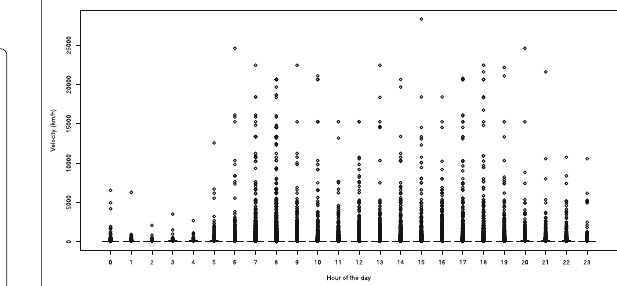
ger, light-goods and heavy-goods vehicles. The number of vehicles, common locations, entry-exit behavior, stopping locations and trajectories of different vehicle categories can be compared to each other. This should lead to a bet- ter understanding of urban transport and hence to better and more informed decision making.